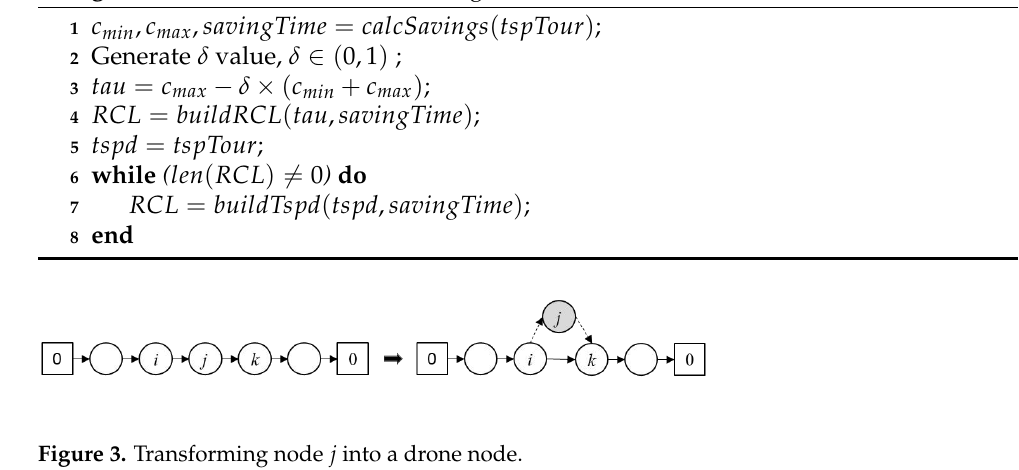
Figure 3. Transforming node j into a drone